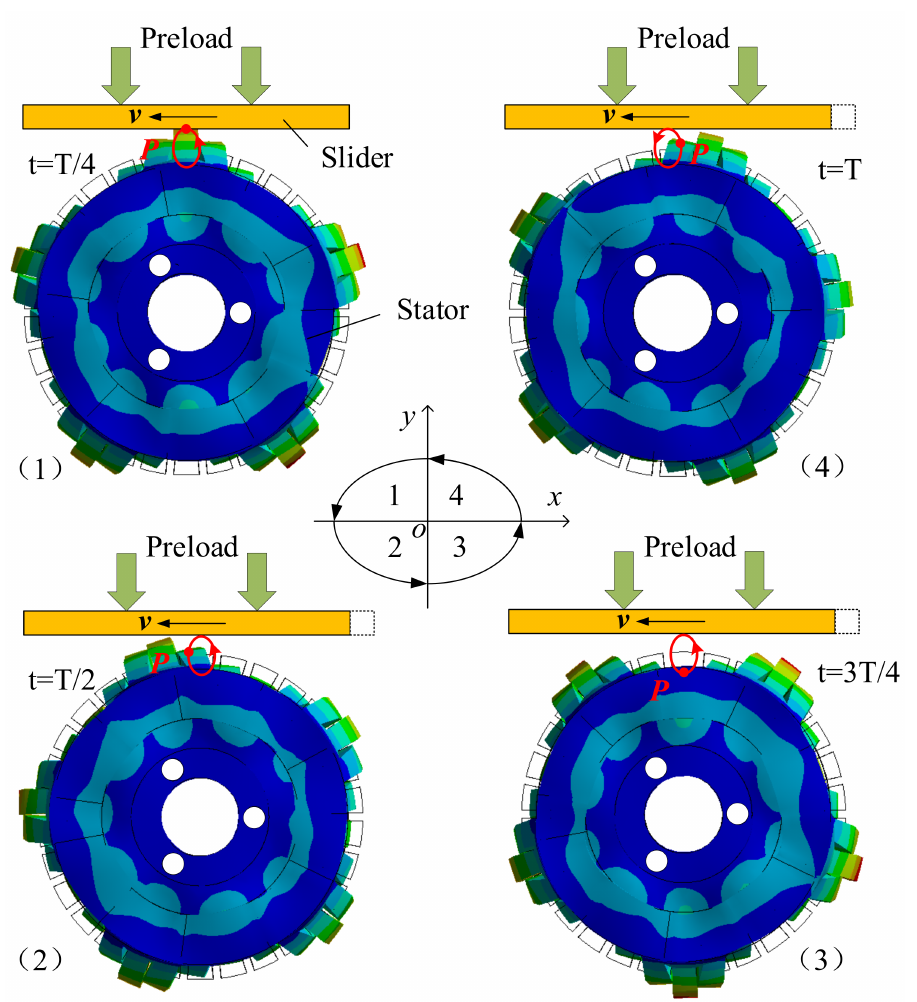
Figure 5. Operating mechanism of the